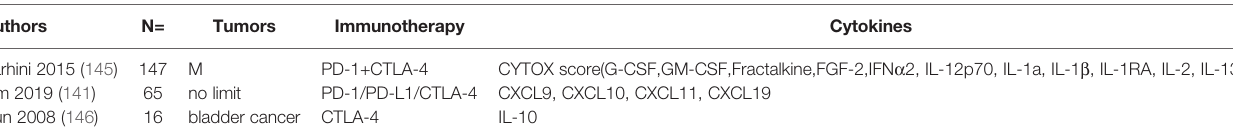
TABLE 4 | Clinical studies of the association of ICT irAEs with other cytokines.